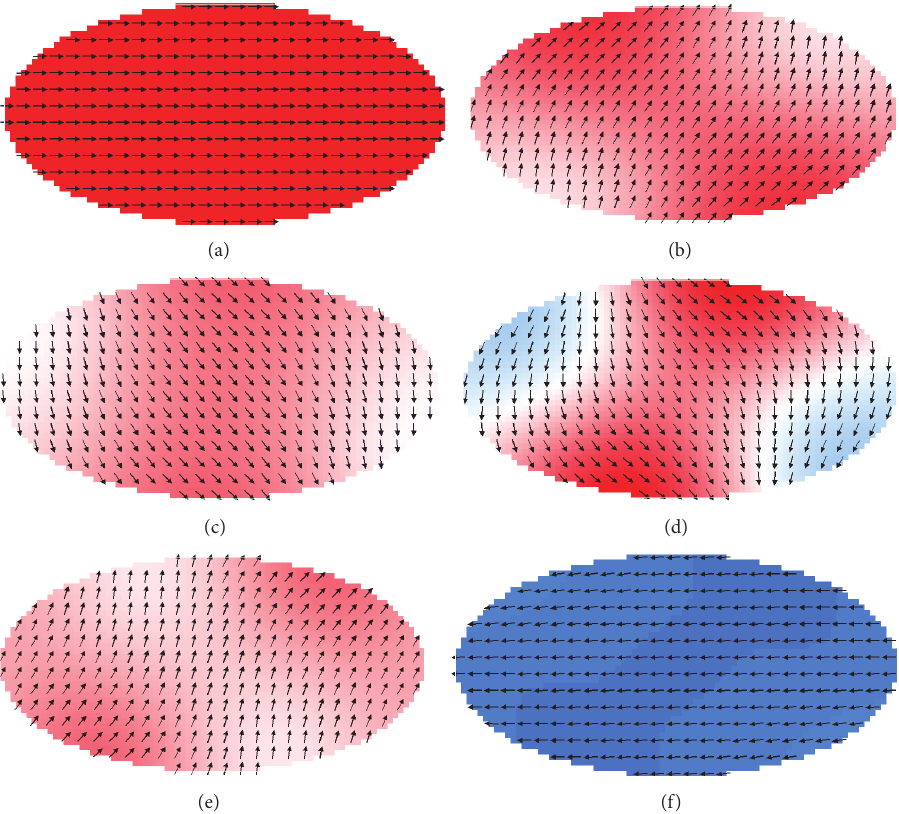
Figure 7: Magnetization spatial distribution corresponding to Figure 6. The snapshots (a) ∼ (f) are picked at 3ns, 7 ns, 11ns, 15ns, 19ns, and 23 ns during the switching